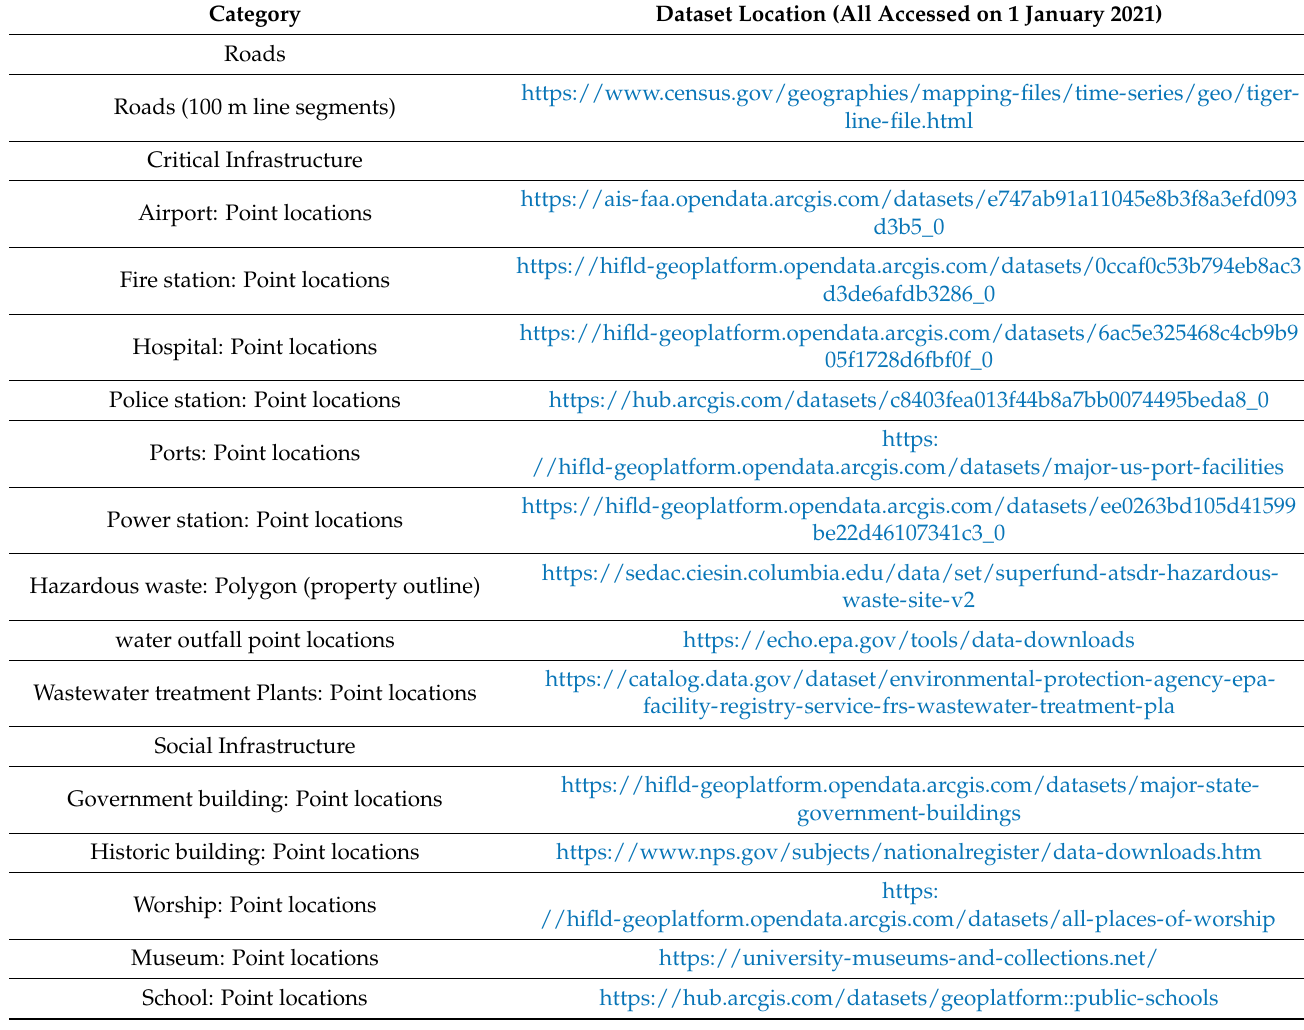
Table 1. Data sources used to analyze the impact of infrastructures and